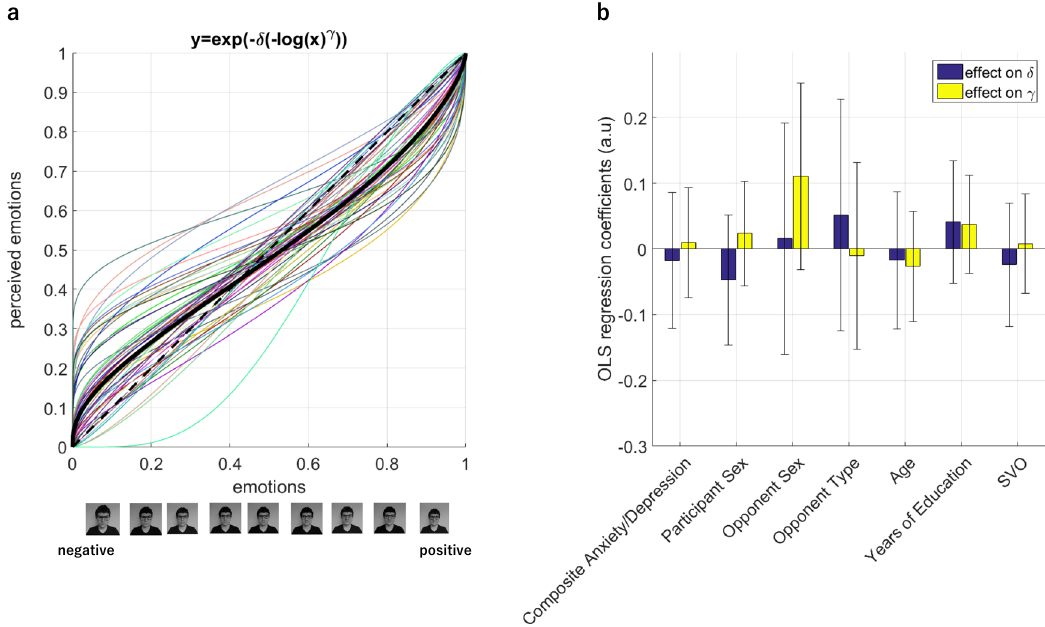
Fig. 2 Results of the facial emotion rating task. a Participants perceived their opponent ’ s facial emotions nonlinearly. The x-axis shows the proposer ’ s faces assembled from negative to neutral to positive (as in Fig. 1), and the y-axis represents participants perceived emotions according to the best- fi tting nonlinear weighting model. The thick black line designates the population mean. b The model parameters [ δ , γ , see Eq. (1)] were not in fl uenced by factors such as symptoms of depression and anxiety, or participant and proposer sex. Composite depression and anxiety scores were established for each participant by linearly transforming (i.e. summing up scores from each domain within subjects) the z-scores of depression, and state and trait anxiety measures to avoid collinearity in the model, as these measures were highly correlated with each other in this cohort of non-clinical volunteers (all r (42) > 0.69, all p < 0.001). Opponent type designates whether participants were told they would be playing against a human confederate or a computerised proposer. SVO: Social Value Orientation, which is a continuous measure de fi ning one ’ s degree of prosociality. All regressors were normalised before model fi tting to allow a direct comparison. Error bars denote 95% CI. Variance in fl ation factor (1/(1 − R 2 )) computed for this model ranged between 1 and 1.06, where values greater than 5 would raise concerns for multicollinearity between regressors. The same set of regressors were used for the analysis reported in Fig.